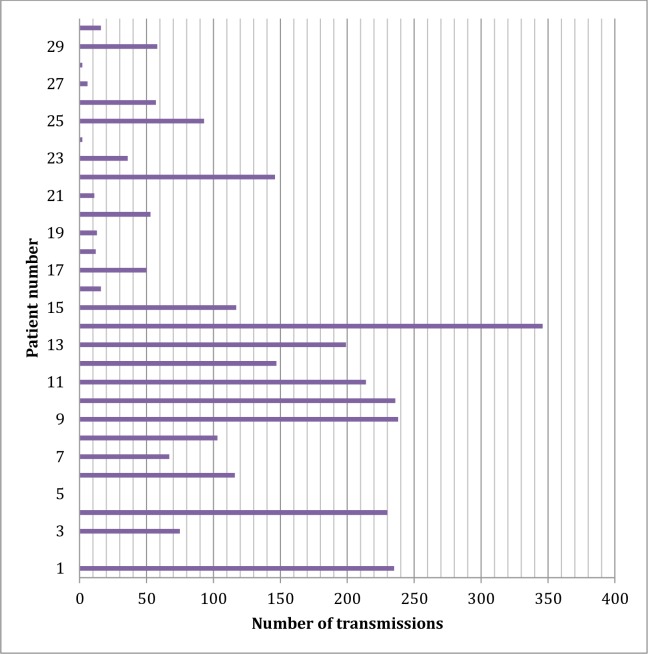
Number of transmissions per patient (patient 2 had ILR explant for infection soon after implant with no downloads prior, hence no data available.The device was misplaced following the death of patient 5 and the patient had not downloaded any data prior to death).